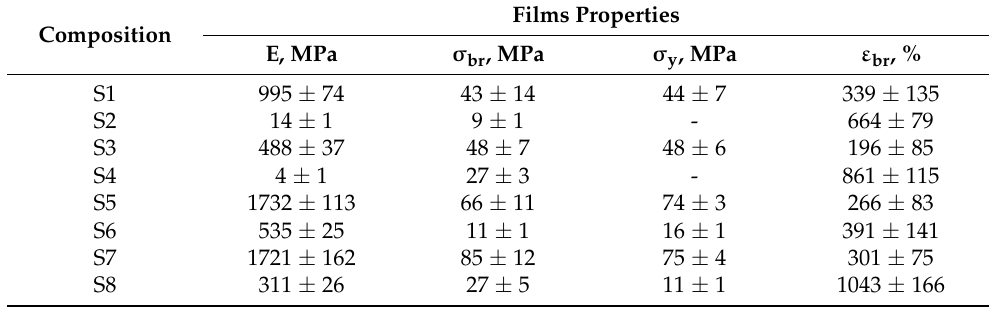
Figure 12. Dependences of the neutron scattering cross section on the momentum transfer for dif ‐ ferent stages during the temperature experiment for S6 ( a ) and S4 ( b ). The solid black lines are Table 5. Mechanical characteristics of the segmented PUUs films. approximation according to Eq. 4.